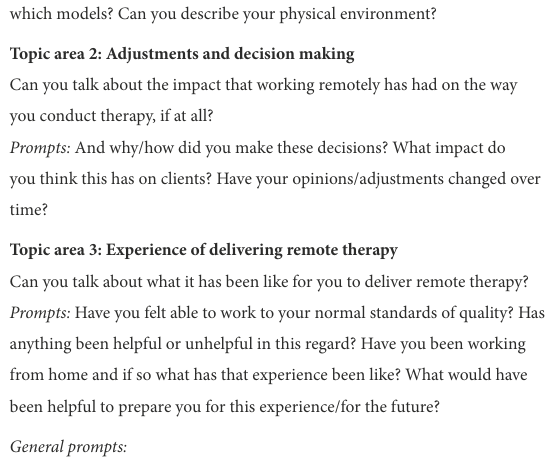
TABLE 3 Super-ordinate themes and corresponding sub-ordinate themes. Coping with COVID: